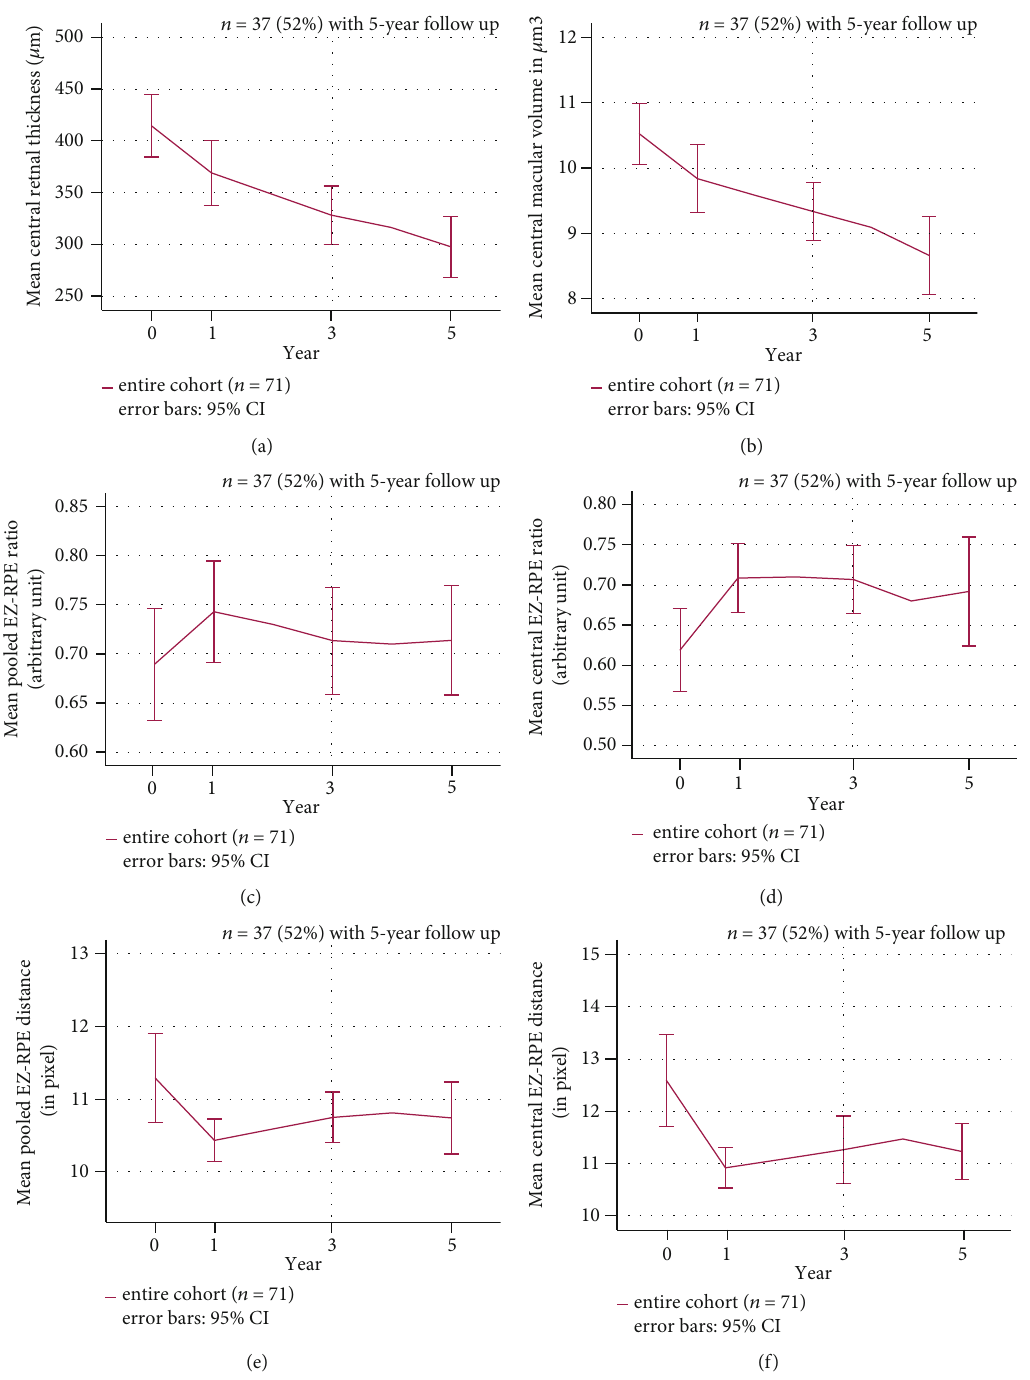
Figure 3: Longitudinal changes of OCT parameters from baseline to fi fth year. Purple line represents the entire cohort ( n = 71 until year 3). The 95% con fi dence interval is represented by error bars. (a) Central retinal thickness and (b) central macular volume decreased signi fi cantly during continuous therapy ( p < 0 : 05 ). (c, d) show mean pooled and central EZ-RPE re fl ectivity ratio changes. (e, f) demonstrate mean pooled and central EZ-RPE